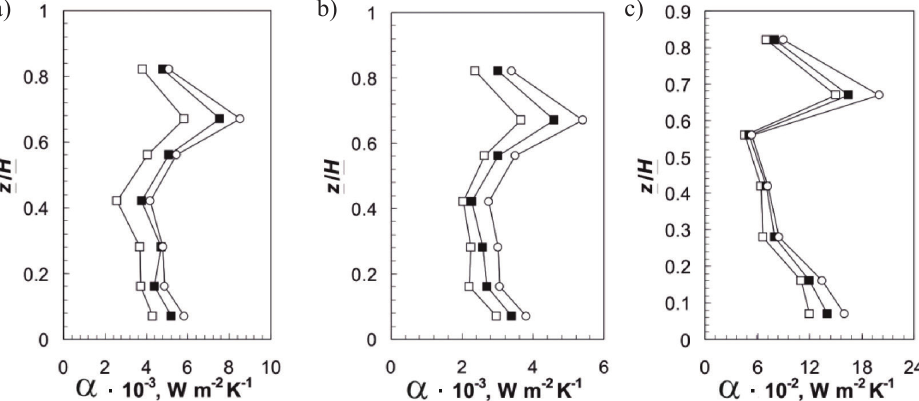
Fig. 4 – Axial distributions of heat transfer coefficient a , Re ≠ const; A 315-RT; a) distilled water,  – Re = 45000;  – Re = 60000;  – Re= 75000; b) 30 % aqueous solution of glucose,  – Re= 15000;  – Re = 20000;  – Re = 25000; c) glycerol,  – Re = 250;  – Re = 300;  – Re = 450; thermal